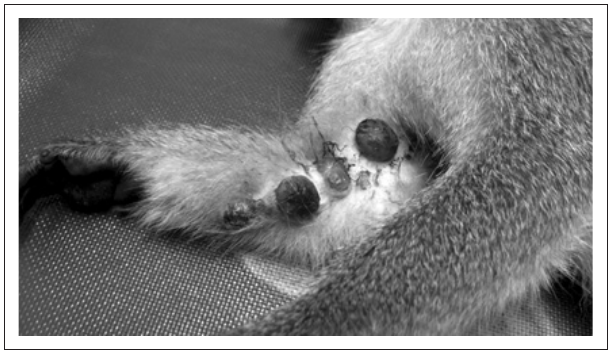
Source : Photo provided by Dr P. Biden FIGURE 1: Multiple raised, firm, congested and ulcerated nodules on the forearm of a vervet monkey, caused by Yaba monkey tumour virus.